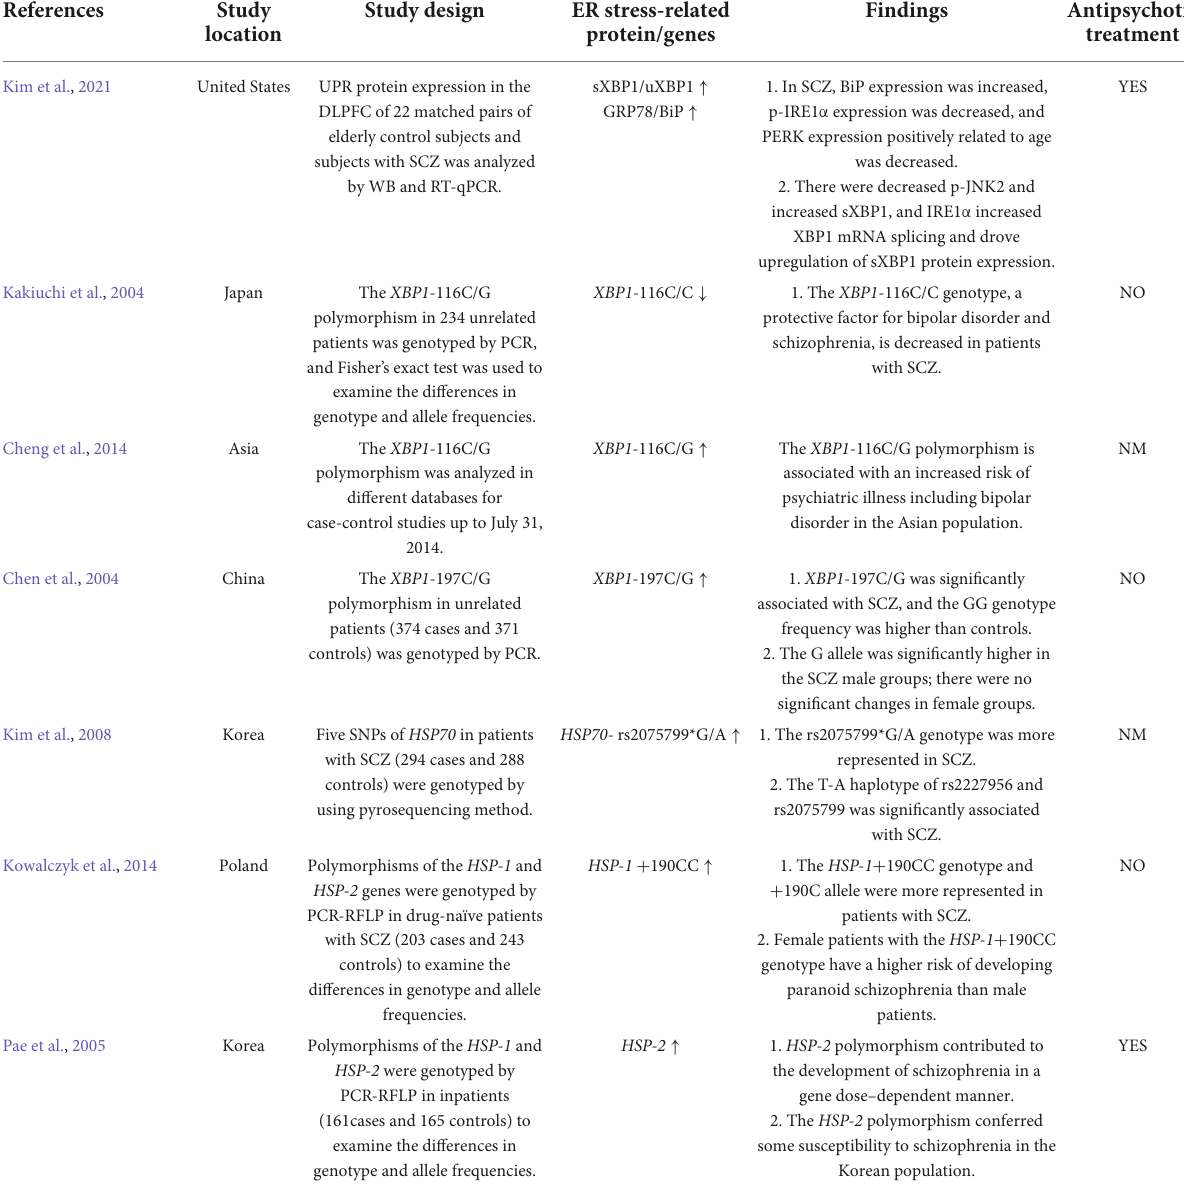
TABLE 2 Clinical studies of ER stress proteins in schizophrenia patients treated with or without